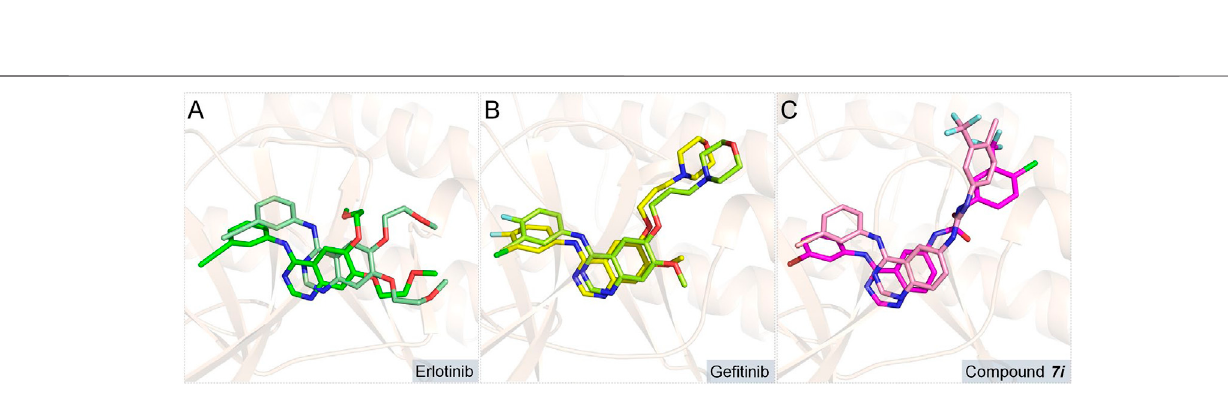
entry ID: 4WKQ). Second, the binding modes of the three dynamic simulation. Figure 4 shows that all docking